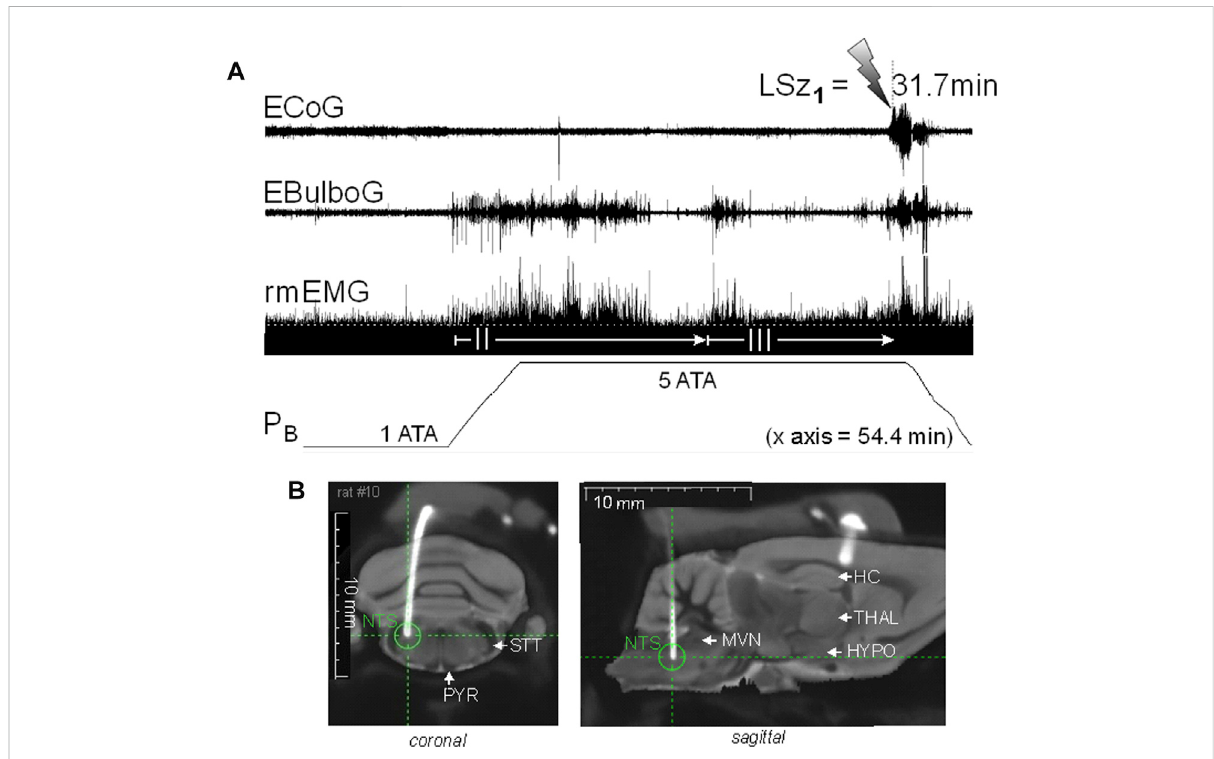
FIGURE 3 Increasinginspiredoxygenfrom1to5ATAstimulatesneuralactivityintheDCMandbreathingandagainpriortocorticomotorseizureinafreely behavingmaleSprague-Dawleyrat. (A) Radiotelemetryrecordingsofcortical(ECoG),medullary(EBulboG),andrespiratory(rmEMG)activitiesduring exposure to normobaric hyperoxia (1 ATA) and HBO 2 ( > 1 to 5 ATA); entire record shown is 54.4min in duration. EBulboG activity increased during compression on 100% O 2 and remained intermittently active until onset of seizure (lightning bolt). The LSz 1 measured from 3 ATA to onset of ictal ECoG activity and visible seizure was 31.7 min. EBulboG activity increased 33.6 min before increased ECoG activity. EBulboG activity also correlated with increased ventilation during exposure to HBO 2 . Respiration did not decrease initially when breathing 1 ATA O 2 , thus there was no phase I HO 2 VR as sometimes is the case (see text). Phase II HO 2 VR is evident and quite long while phase III waxes and wanes until surging ~4 – 5min prior to Sz. (B) Composite CT-MRI image showing location of deep tungsten electrode in the CDM, which was on the border of the NTS and the parvicellular reticular nucleus. HC, hippocampus; HYPO, hypothalamus; MVN, medial vestibular nucleus; NTS, nucleus tractus solitarius; PYR, pyramids; STT, spinotrigeminal tract; THAL,